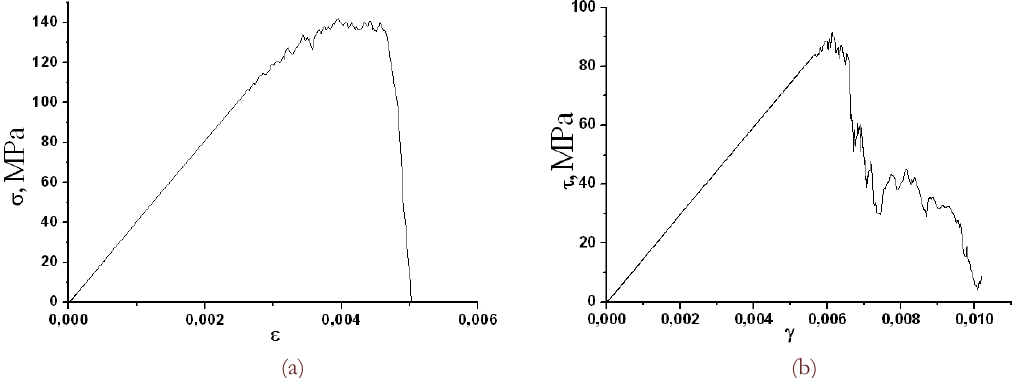
Figure 3: Loading diagrams of the model specimen with dimension of 22.5 mm under uniaxial compression (a) and shear loading